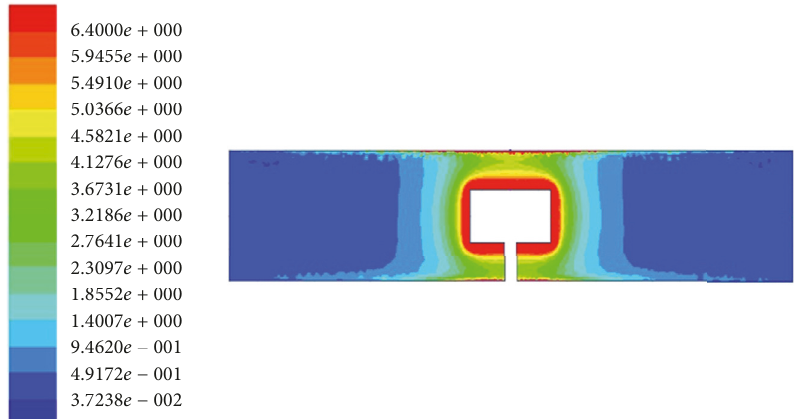
Figure 2: The simulated current distribution on the antenna at 915 MHz.